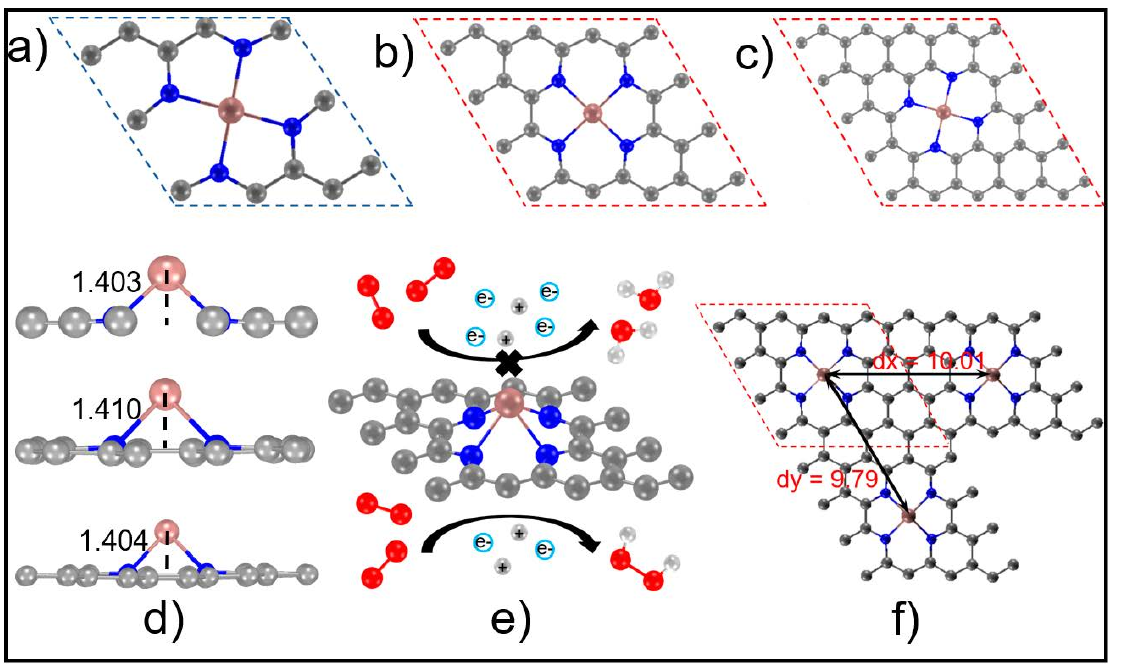
Figure 1. ( a – c ) The optimized structure of InN 4 in different unit cells (from left to right are 3 × 3, 4 × 4, 5 × 5); ( d ) The distance that the In atoms on the surface of InN 4 are offset from the two-dimensional plane (from top to bottom are 3 × 3, 4 × 4, 5 × 5); ( e ) the ORR process that occurs on the InN 4 surface; ( f ) the distance between InN 4 adjacent metal In atoms in 4 × 4 unit cell. The unit of distance in the figure is Angstrom (Å) and gray-black, off-white, red, blue, and maroon are C atoms, H atoms, O atoms, N atoms, In atoms, respectively.